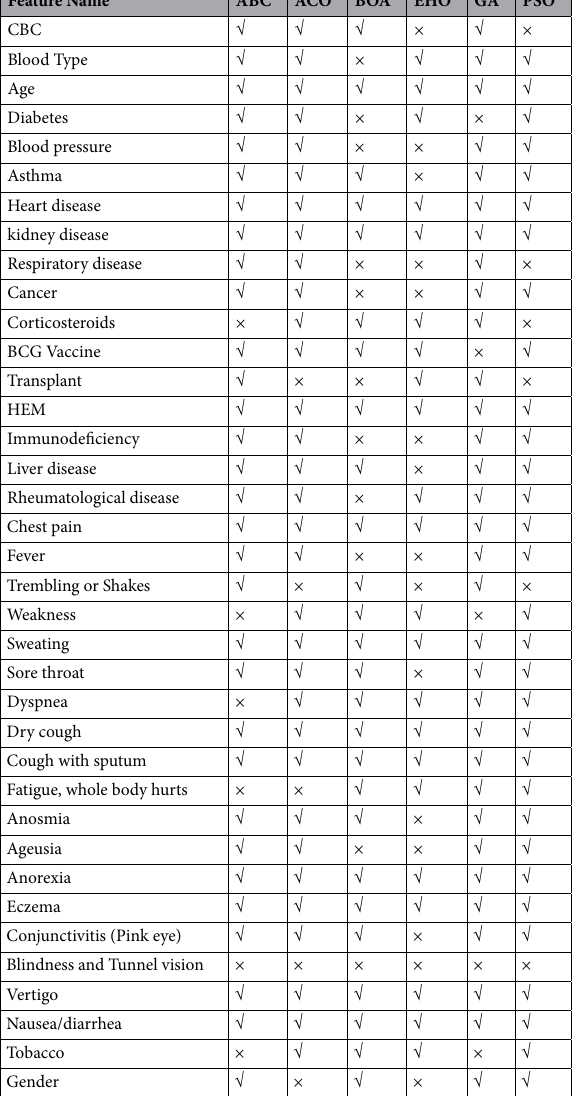
Table 10. Selected features by various meta-heuristic methods: (√) selected feature, (×) discarded feature.